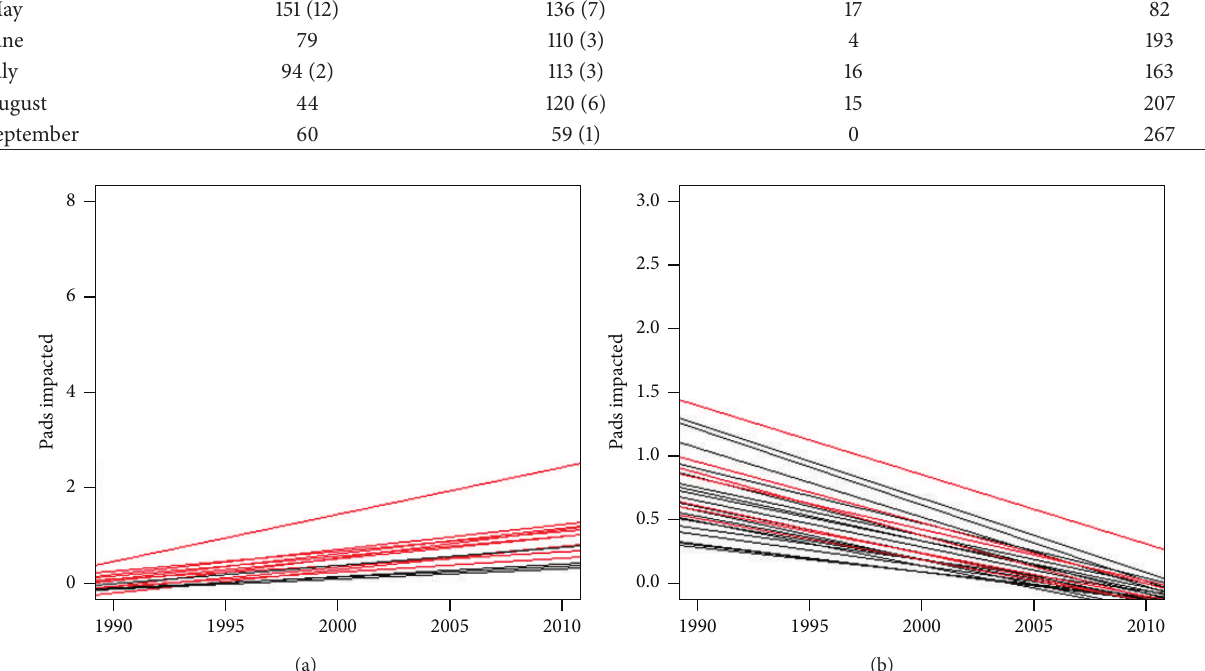
Figure 4: Linear trends of hailpad stations with significant trends. (a), upward trends; (b), downward trends. In black, trends of the Atlantic area; in red, trends of the Midi-Pyr´en´ees